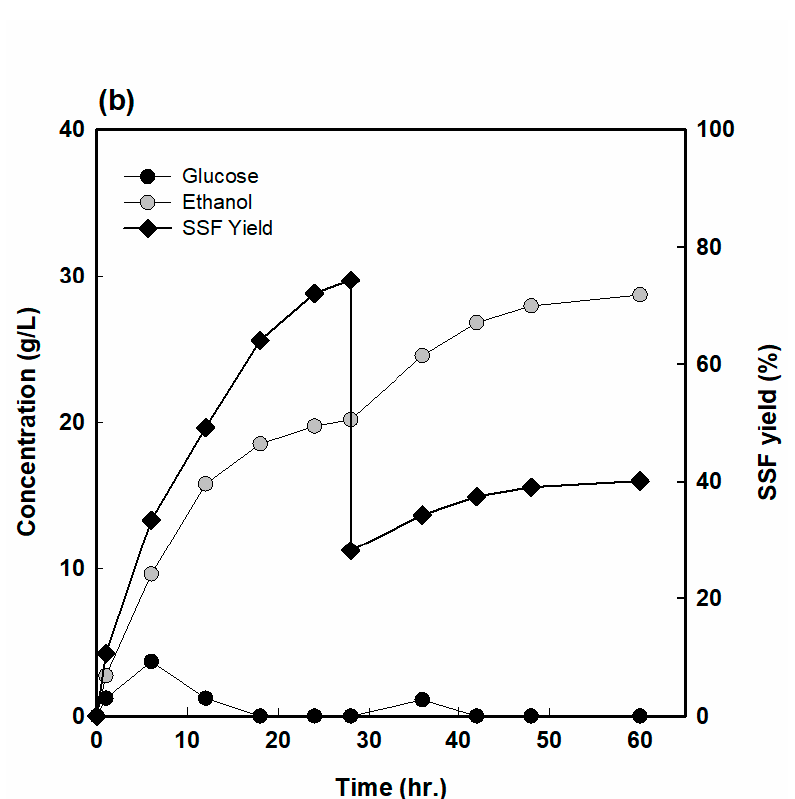
Figure 6. Bioethanol production from the alkaline fractionation of RH using a two-stage fed-batch SSF: ( a ) a strategy for solid addition (top); ( b ) time courses of bioethanol production and glucose consumption (bottom).